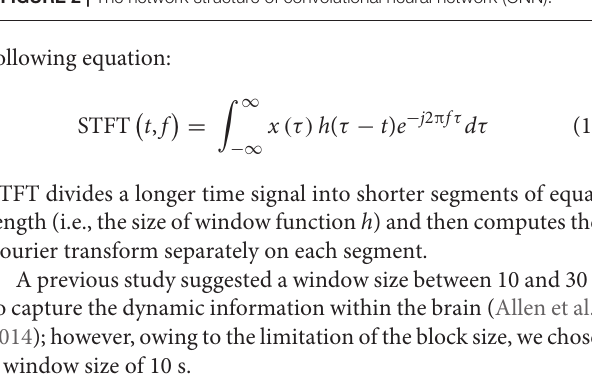
FIGURE 2 | The network structure of convolutional neural network